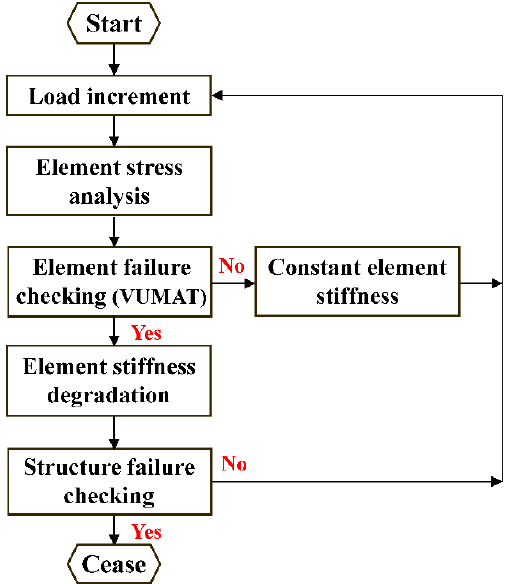
Figure 6. Calculation process of the bolt progressive damage.